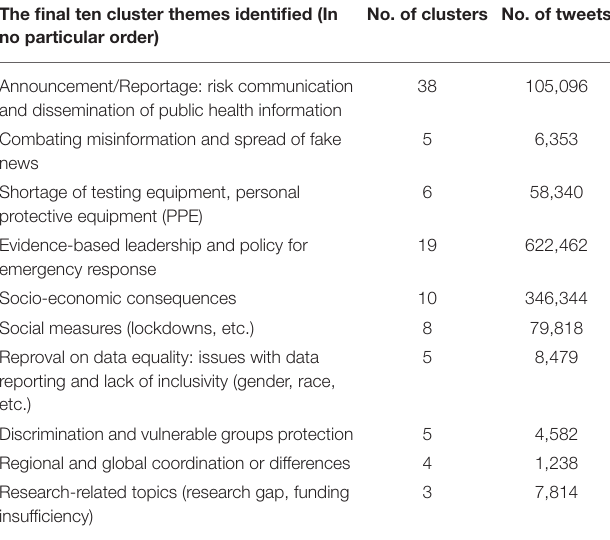
TABLE 2 | Ten cluster themes and number of clusters and tweets in each